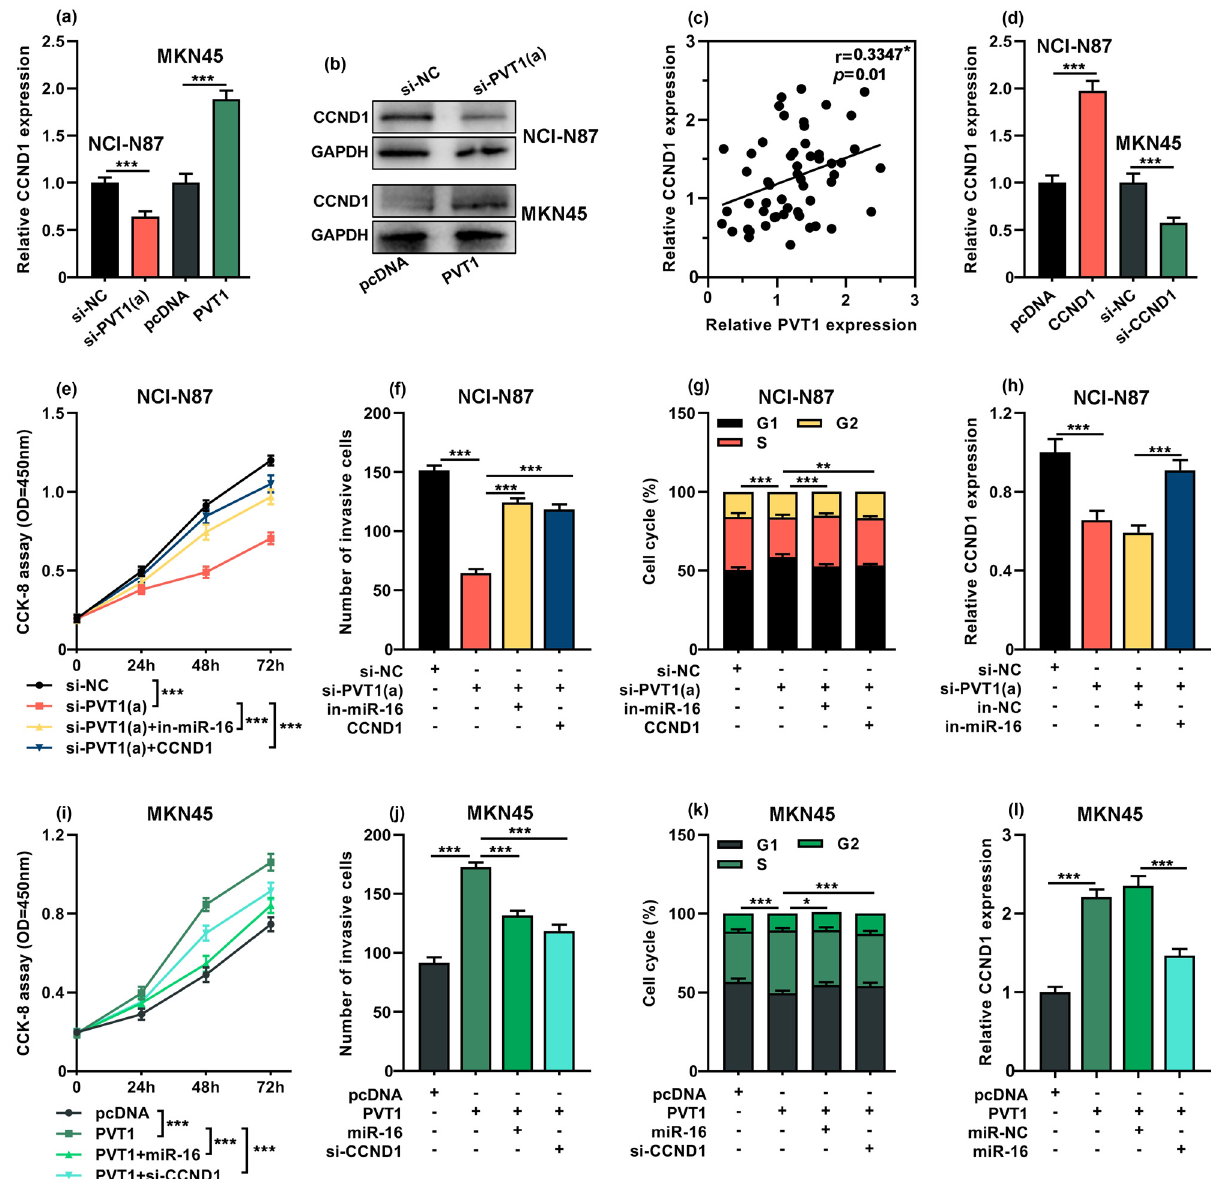
Figure 5: PVT1 promoted GC progression by regulating miR - 16/CCND1. ( a and b ) qRT - PCR and western blot were used to measure